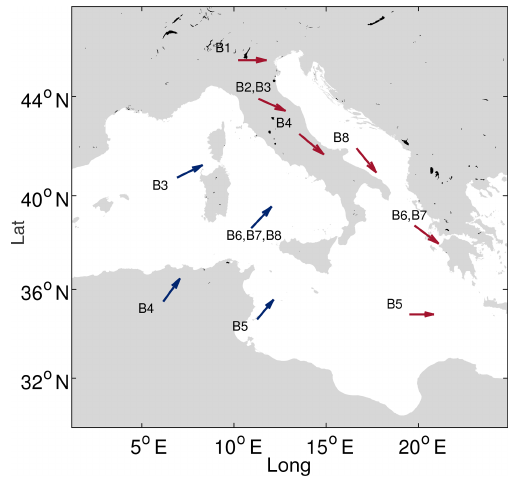
Figure 7. Time evolution of the center of the low pressure for the different WP identified for each buoy. In blue – WPs with lows trav- eling northeastward (WP#1); in red – WPs with lows traveling east- ward or southeastward (WP#2).